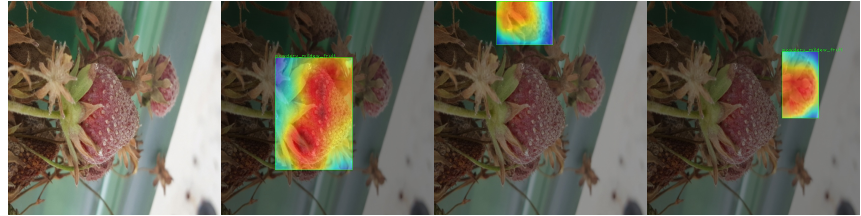
Figure 23. Grad-CAM test on Powdery Mildew Fruit sample.